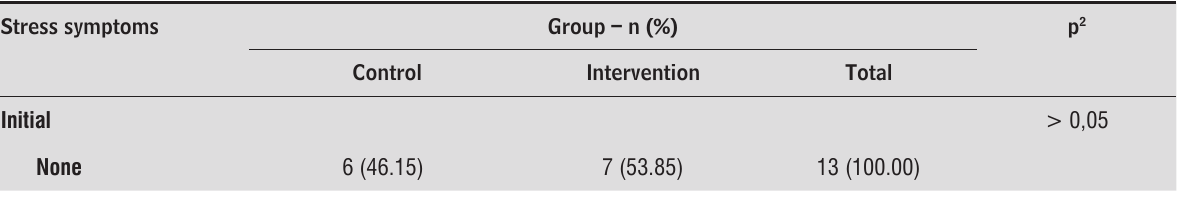
Table 2 - Distribution of number of occurrences (n) of the stress symptoms in percentages according groups Stress